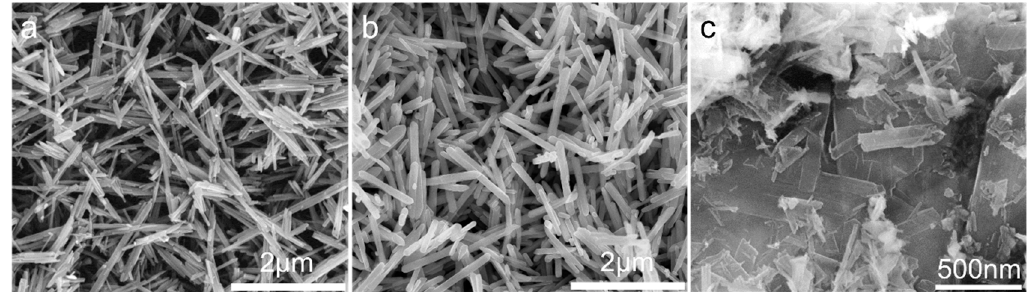
Figure 2. SEM images of ( a ) α -MnO 2 , ( b ) β -MnO 2 , and ( c ) δ -MnO 2 .